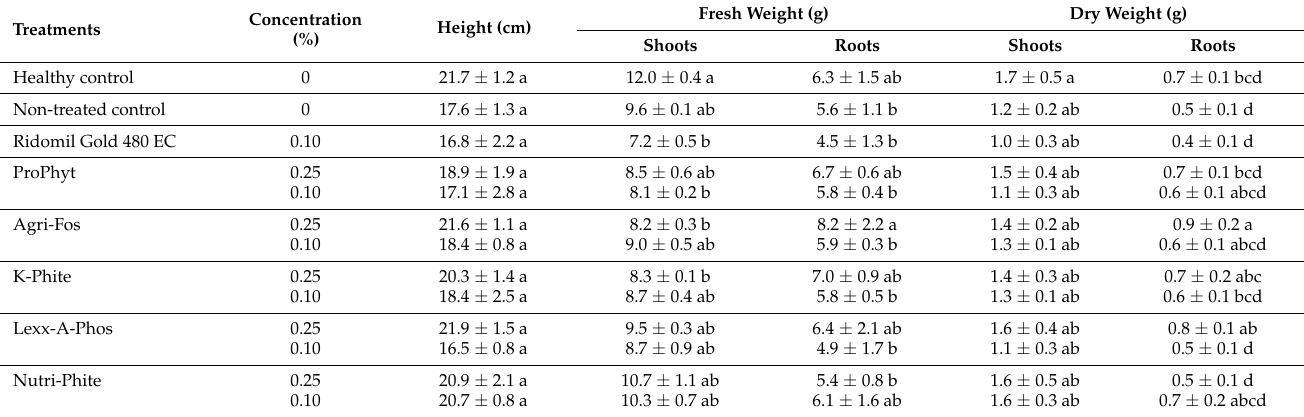
Table 3. Effect of phosphorous-acid-containing products on plant height, fresh and dry shoots, and roots of bell pepper seedlings